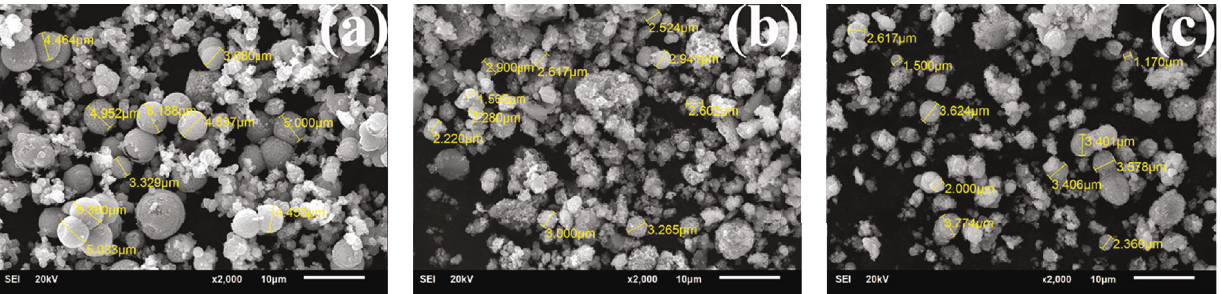
Figure 6: SEM images of VO